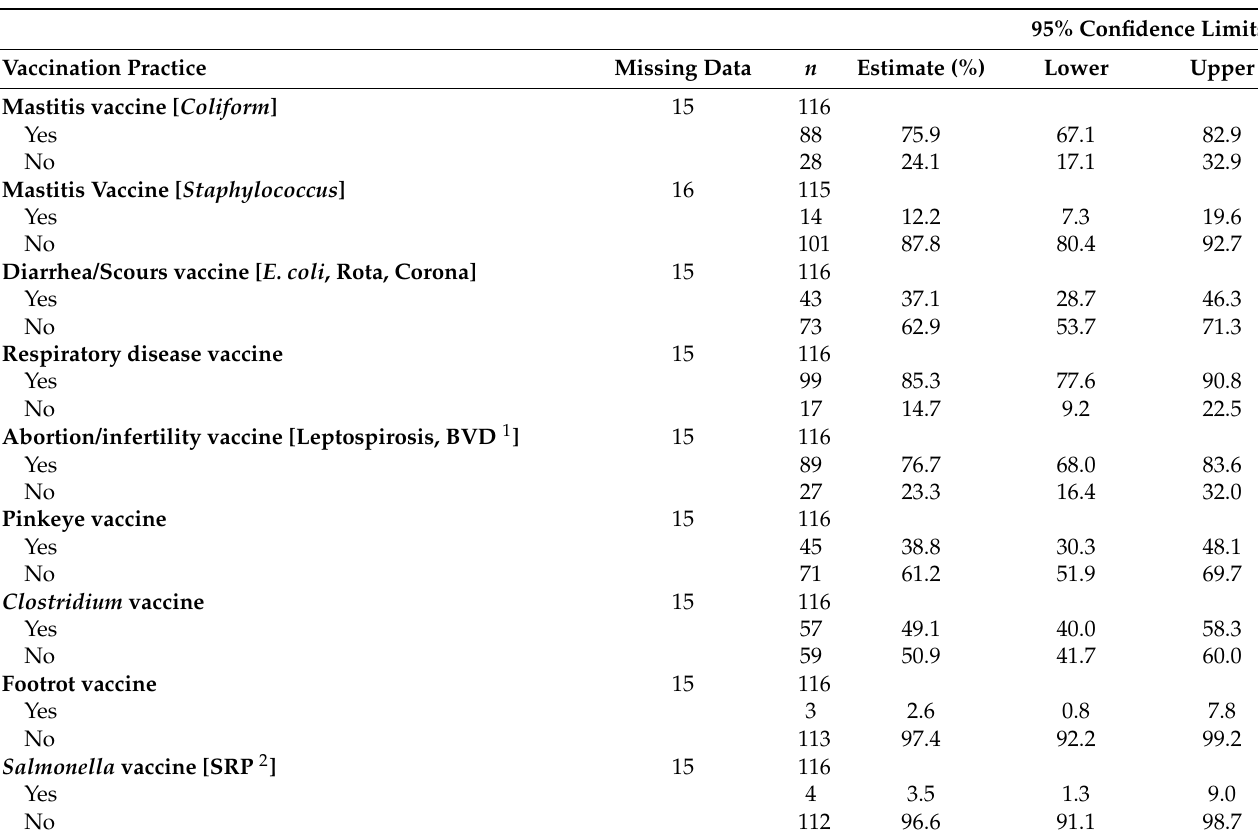
Table 3. Summary of dairy cow vaccination practices from responses to questionnaire on antimicrobial drug use in adult cows on California dairies during 2019.